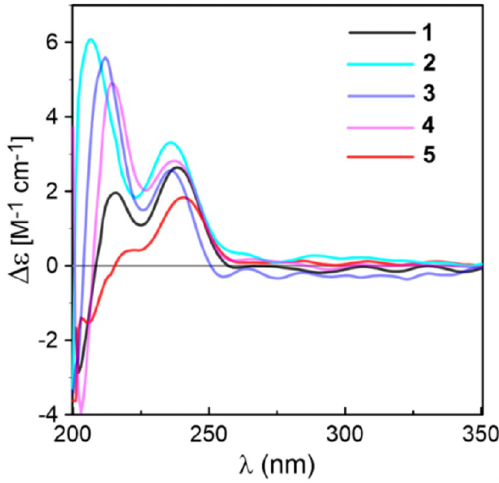
Fig. 4 Comparison of the ECD spectra measured for 1 –